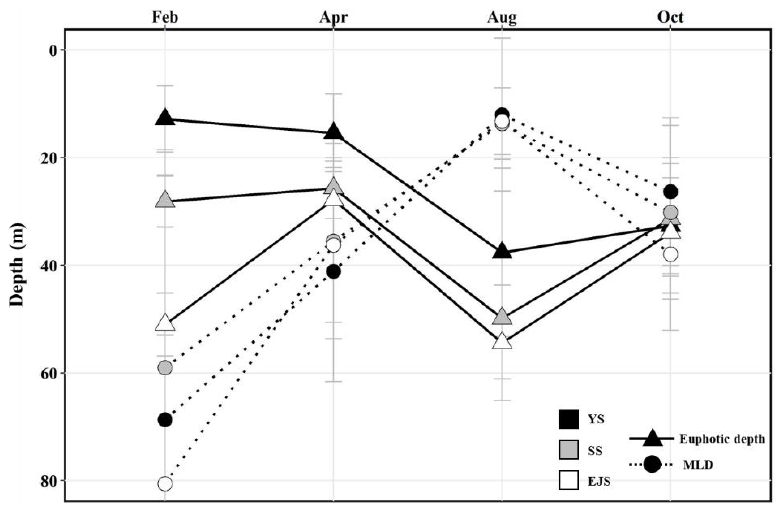
Figure 3. Variation in the mean euphotic and mixed-layer depths in the YS, the SS, and the EJS, 2018.